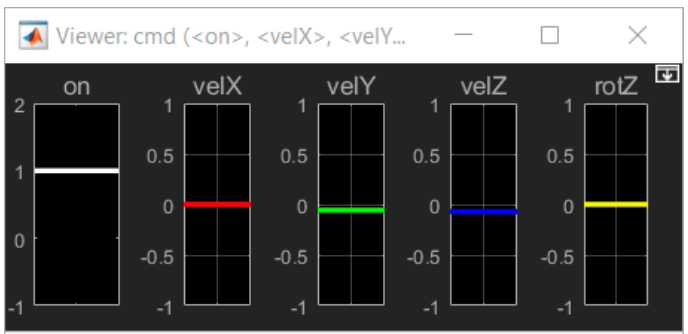
Figure 6. Simulink viewer showing the commanded velocity reference vector 𝐫 = [𝐯 𝜔 (cid:2936) ] (cid:2912) .